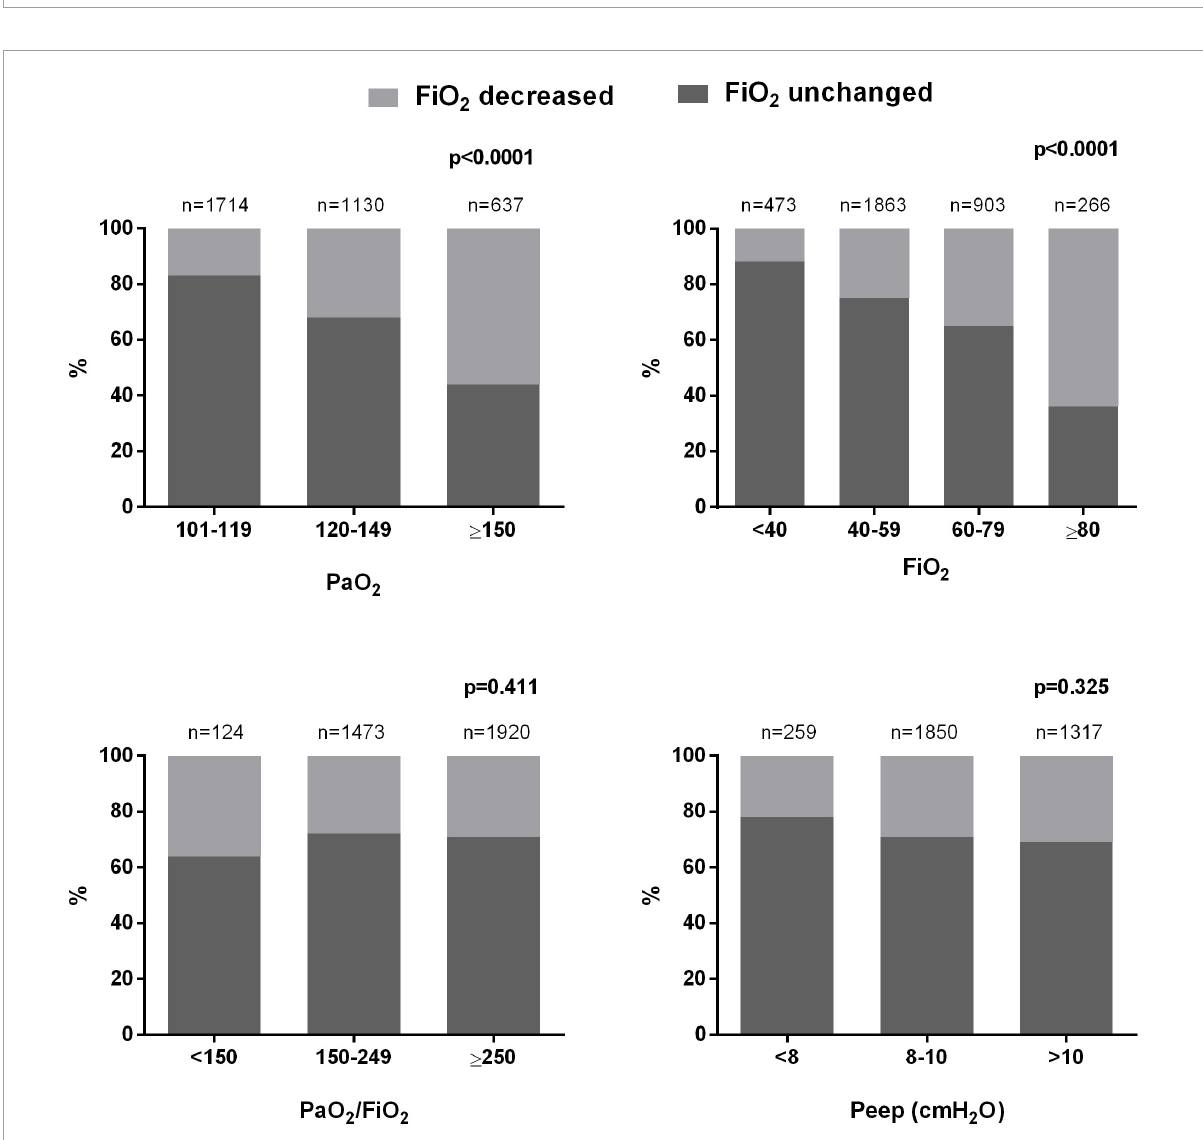
FIGURE2 Episodes of uncorrected hyperoxemia stratified by PaO 2 , FiO 2 , PaO 2 /FiO 2 , and PEEP